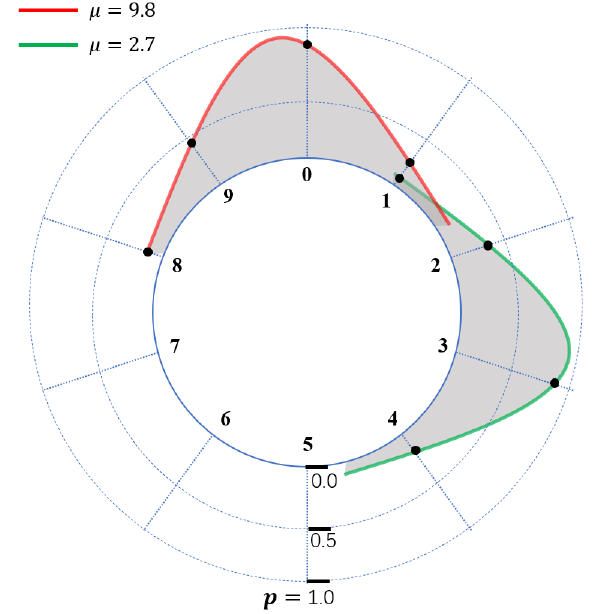
Figure 7. Gaussian Circle Probability Distribution (CPD) centered at different µ values. For each discrete integer in the range [0,9], we sample the corresponding probability(the probability at the black dot) to construct the final ground